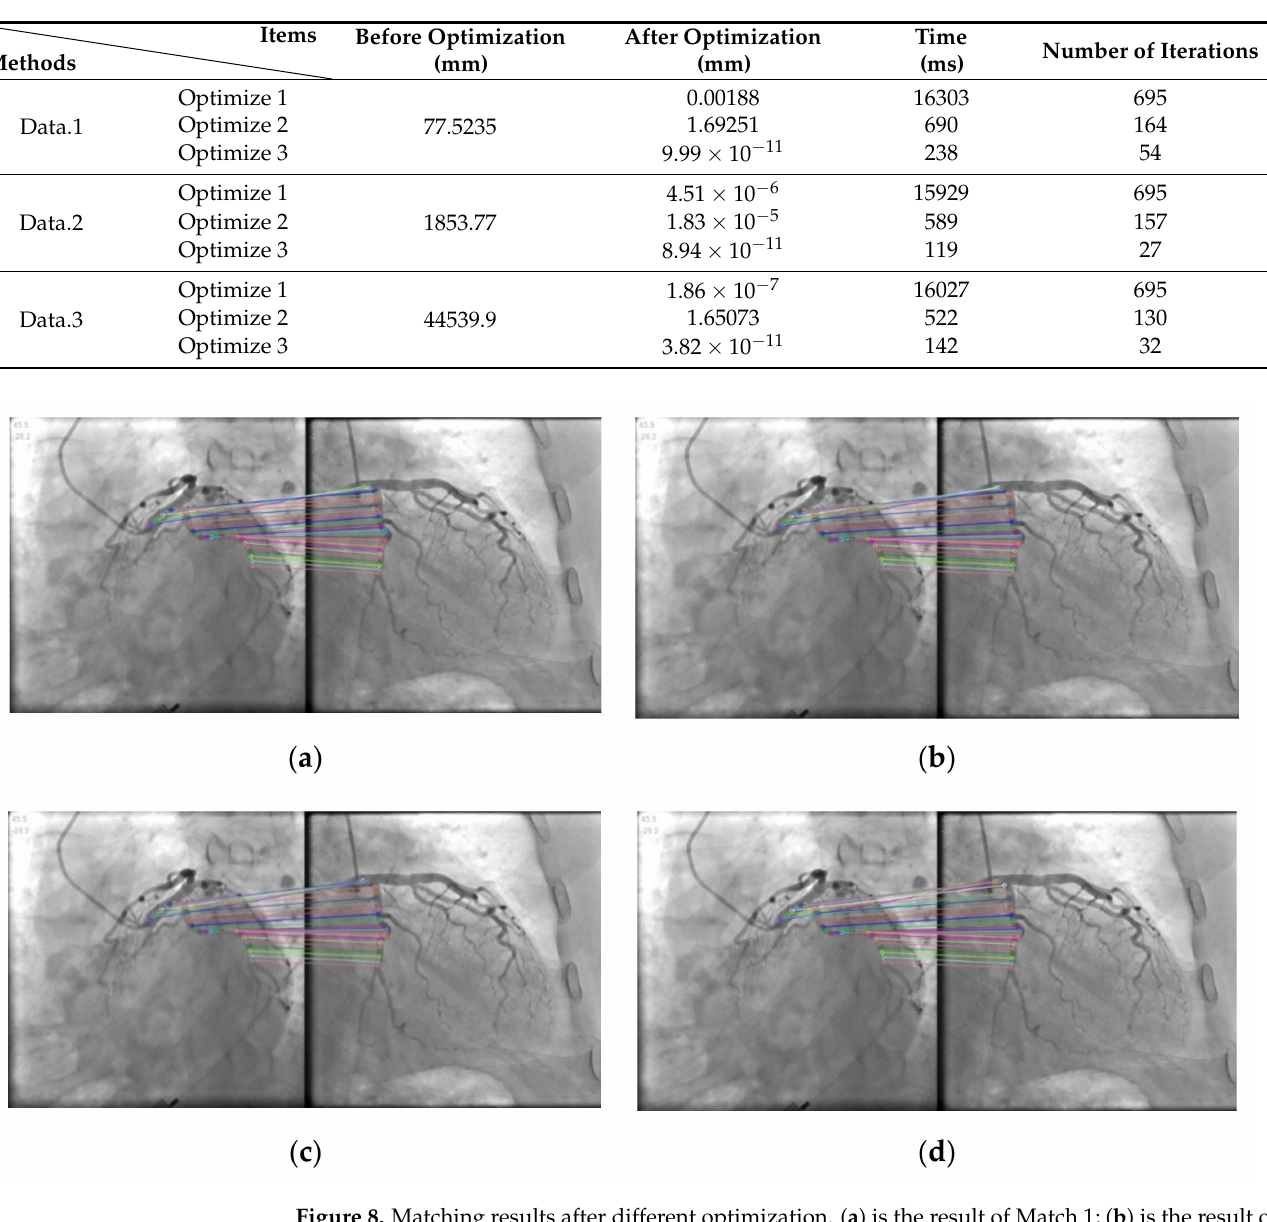
Table 2. Objective function optimization index statistics.